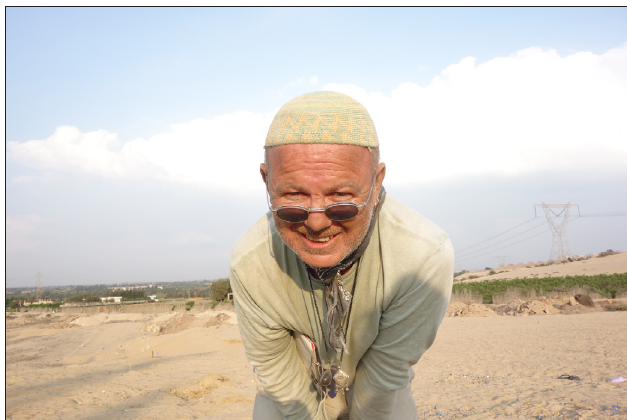
Figure 7: Geoffrey Tassie (“Tass”) on the Wadi el-Gamal at Merimde Beni Salama in 2014 (Photo: Sebastian